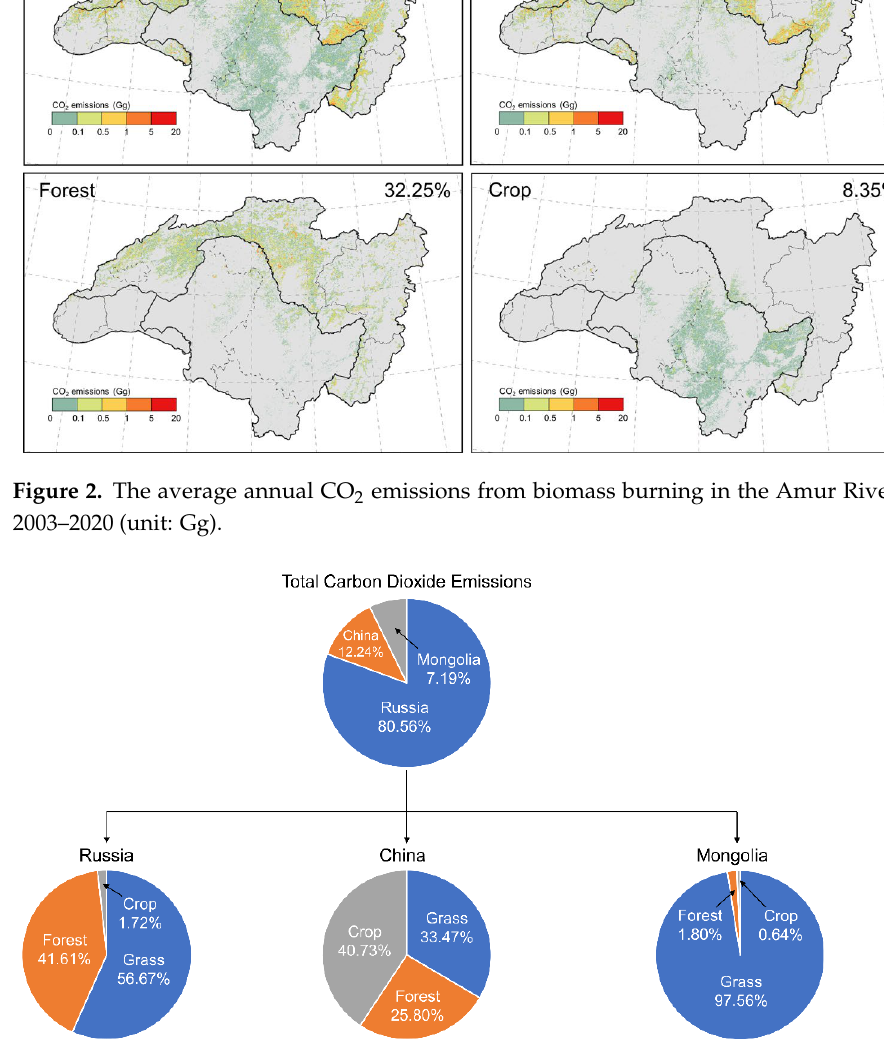
Figure 3. Total CO 2 emissions from biomass burning in the Amur River Basin for 2003–2020.